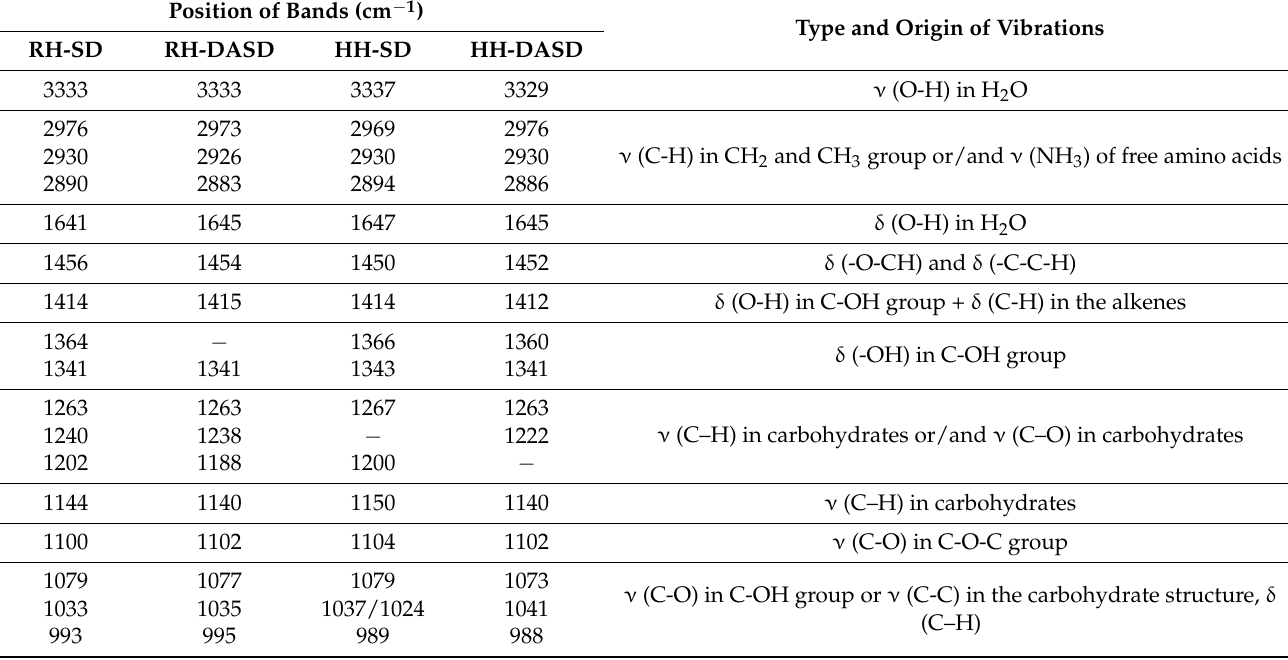
Table 4. The location of the maxima of absorption bands FTIR with the arrangement of appropriate vibration for selected for sampling: RH-SD, RH-DASD, HH-SD, HH-DASD made in terms of spectral 3750–690 cm − 1